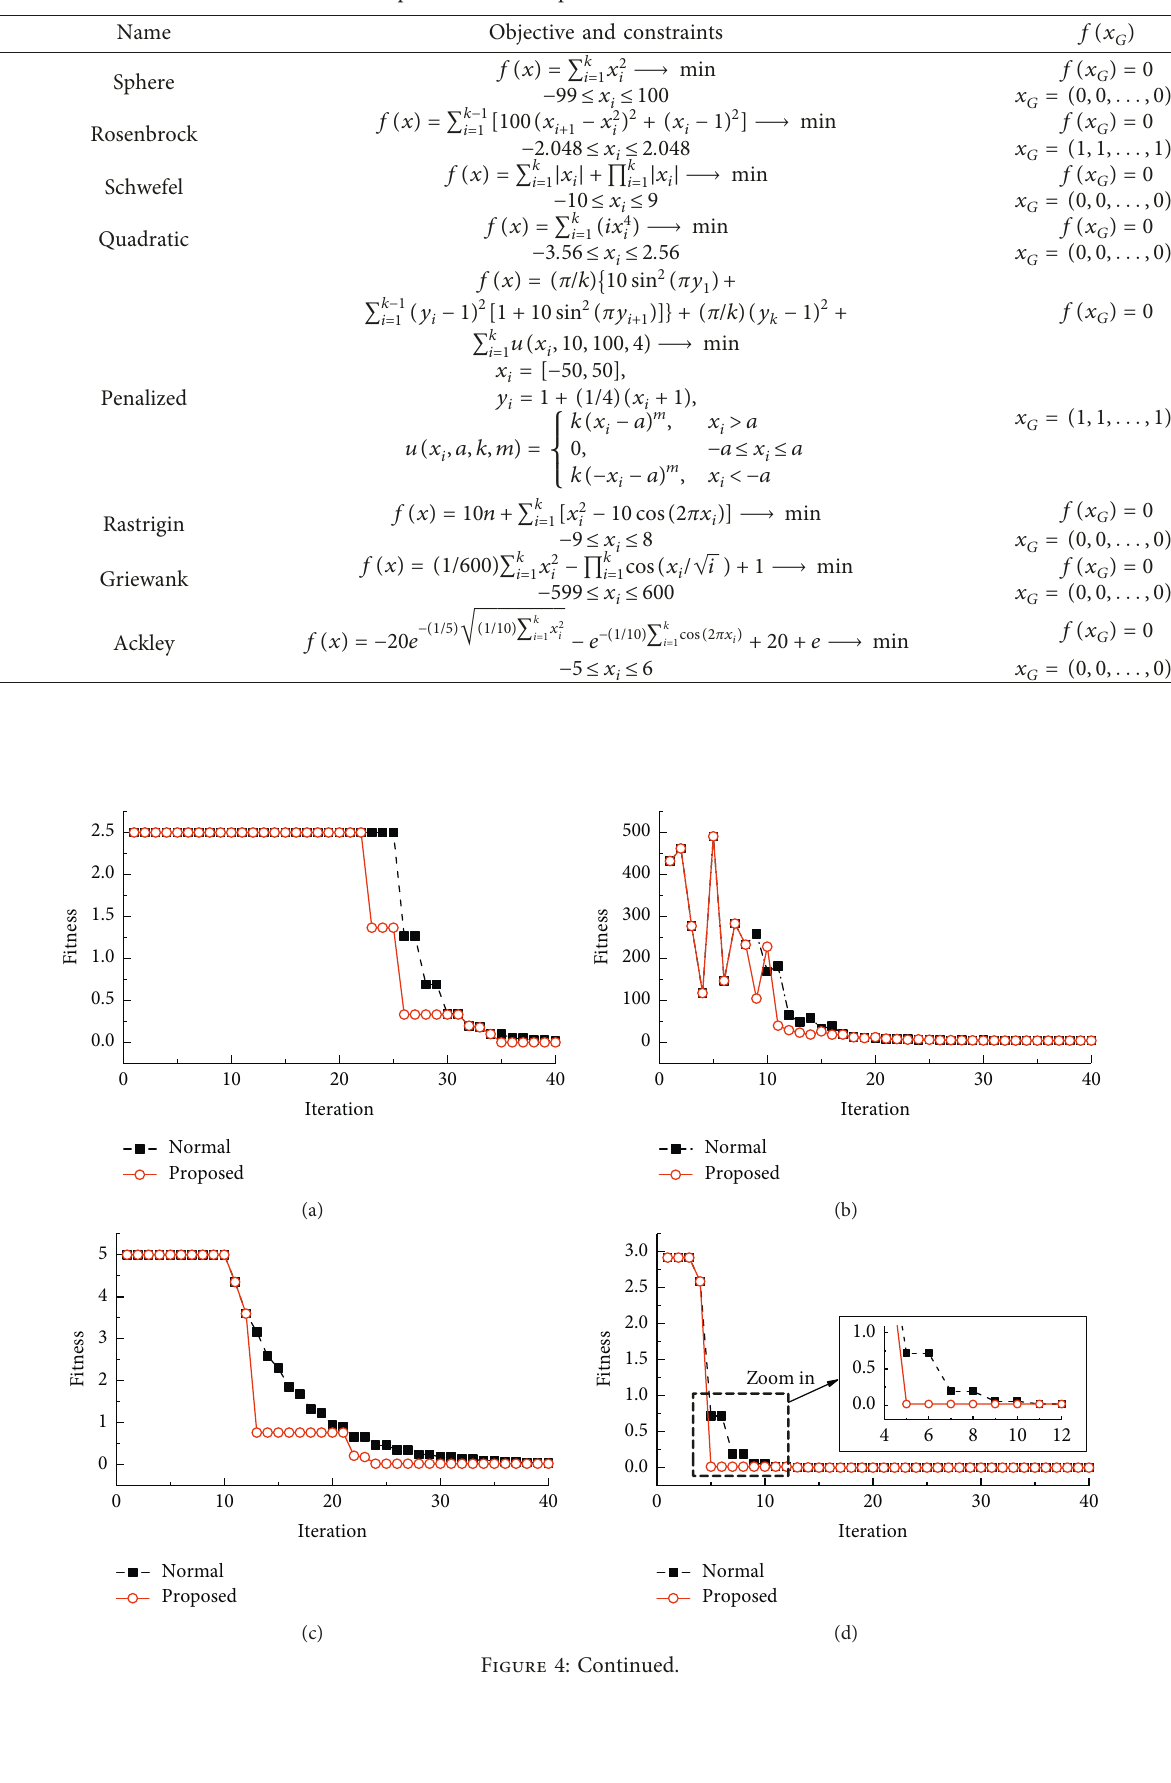
Table 1: Optimization examples of some other test